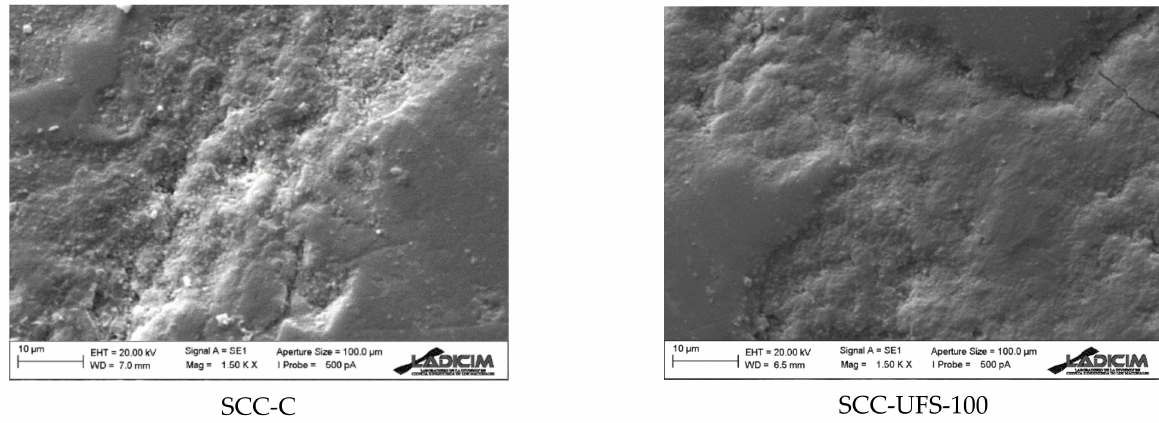
Figure 8. Micrographs obtained at 1500 ×